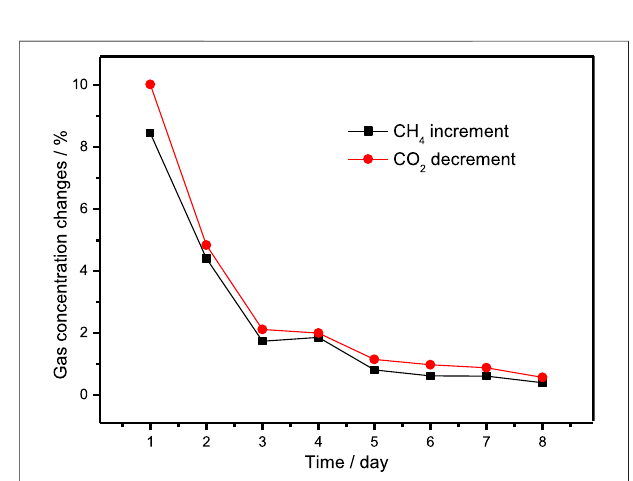
FIGURE 4 | The curve of change of CH 4 and CO 2 concentration in Experiment